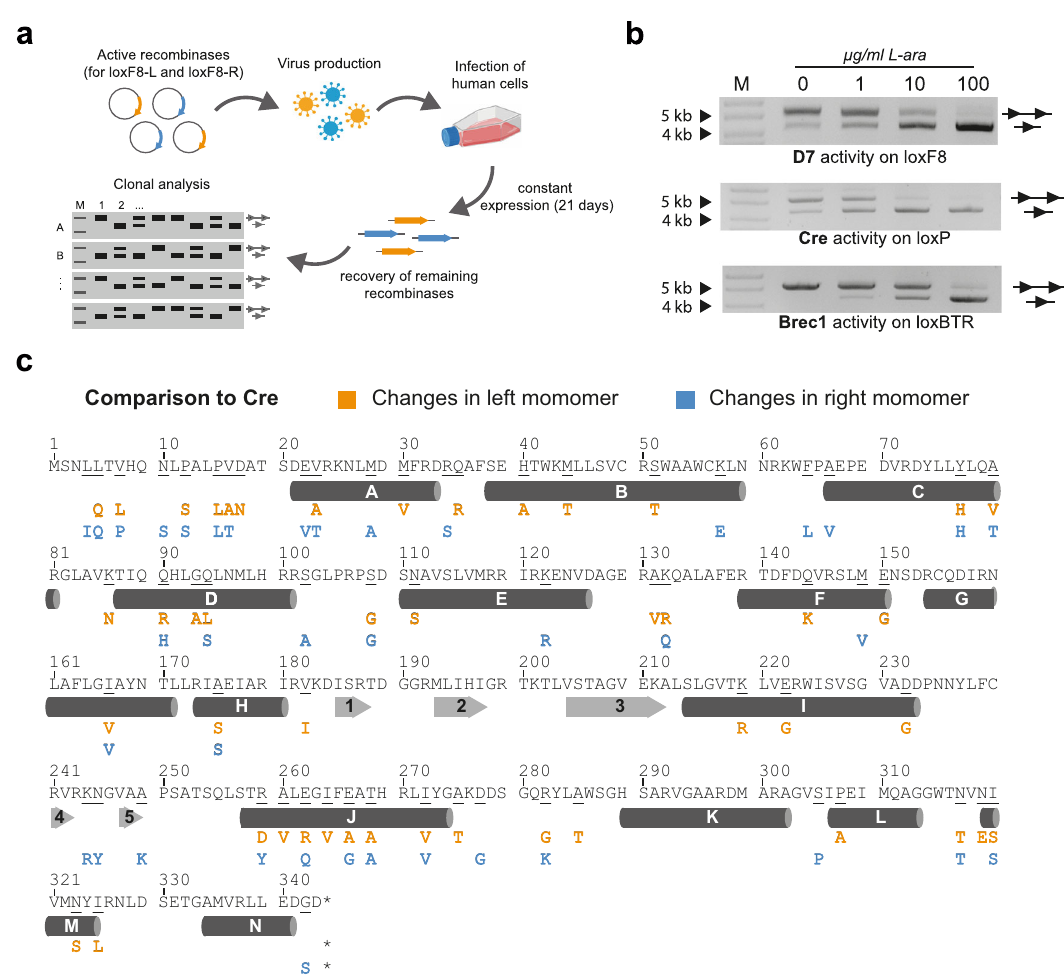
Fig. 2 Identi fi cation of a loxF8 speci fi c heterodimer clone. a Overview of the clone selection procedure. Active recombinases for loxF8-L and loxF8-R are cloned to an inducible lentiviral expression plasmid. Human cells are infected with viral particles each coding for a recombinase from the active libraries. After 21 days of constant expression of the recombinases, genomic DNA of the cells is isolated and recombinase genes are retrieved via PCR. Recombinases are combined in a heterodimer and single clones are expressed in E. coli . Activity of the clones is analyzed using a PCR-based assay. The upper band represents the PCR product generated from non-recombined substrate (line with two triangles), whereas the lower band shows the PCR product generated from recombined substrate (line with one triangle). b Plasmid-based activity assay of the loxF8 candidate recombinase heterodimer (D7), Cre and Brec1. Recombinases were expressed in E. coli at four different L-arabinose concentrations (0, 1, 10, and 100 μ g/ml). The upper band represents non-recombined substrate (line with two triangles), whereas the lower band shows the recombined plasmid (line with one triangle). The marker lane (M) for 4 kb and 5 kb is shown with arrows. c Mutation analysis of the D7 monomers (one-letter code). The amino acid sequence of Cre recombinase is shown as a reference. Orange and blue letters represent changes found in the left monomer and in the right monomer, respectively. Secondary structure elements are indicated, with alpha-helices displayed as cylinders with letters and beta-sheets represented as numbered arrows. Asterisks denote stop codons. Parts of the fi gure were created with BioRender.com. Source data are provided as a Source data fi